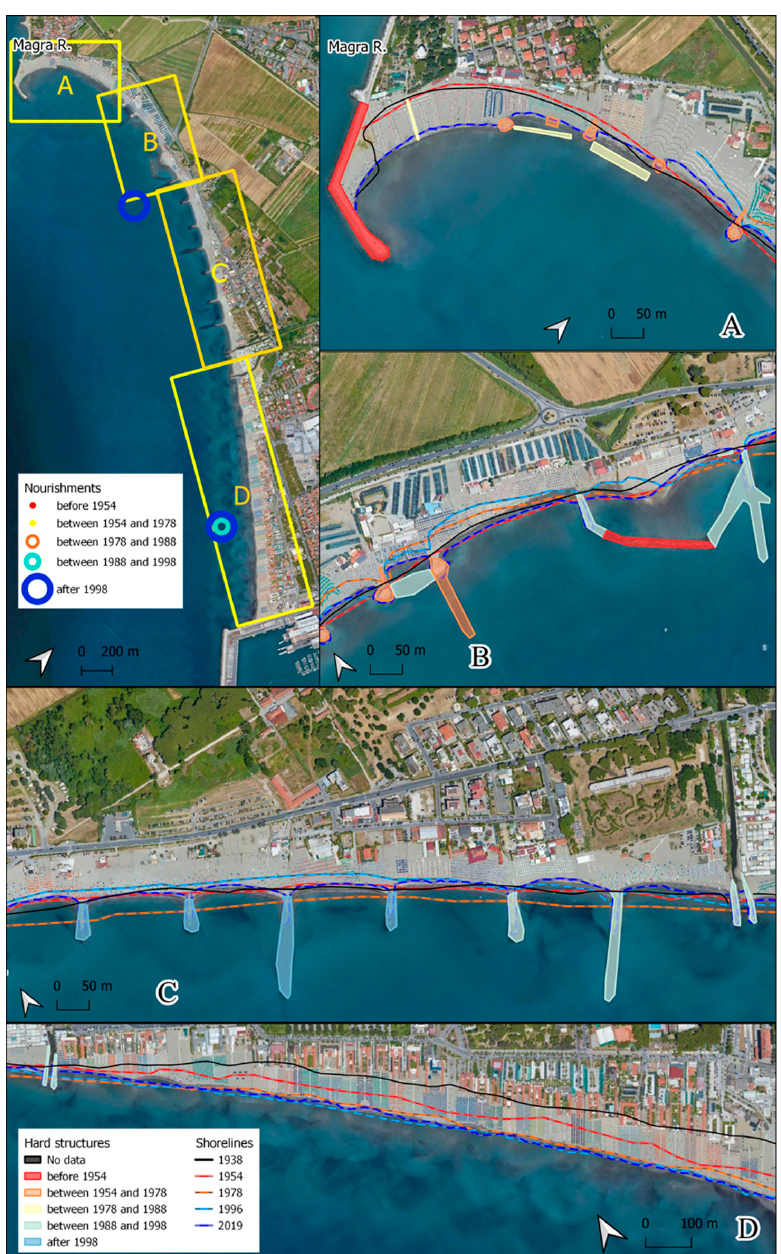
Figure 2. Identification of hard and soft operations along the sector comprised between the Magra River mouth and the Port of Marina di Carrara. Polygons represent the hard structures; dots represent the nourishments. The yellow frames in the top left panel correspond to the zoom in panels to the right and at the bottom. The background image has been retrieved from the Google Earth